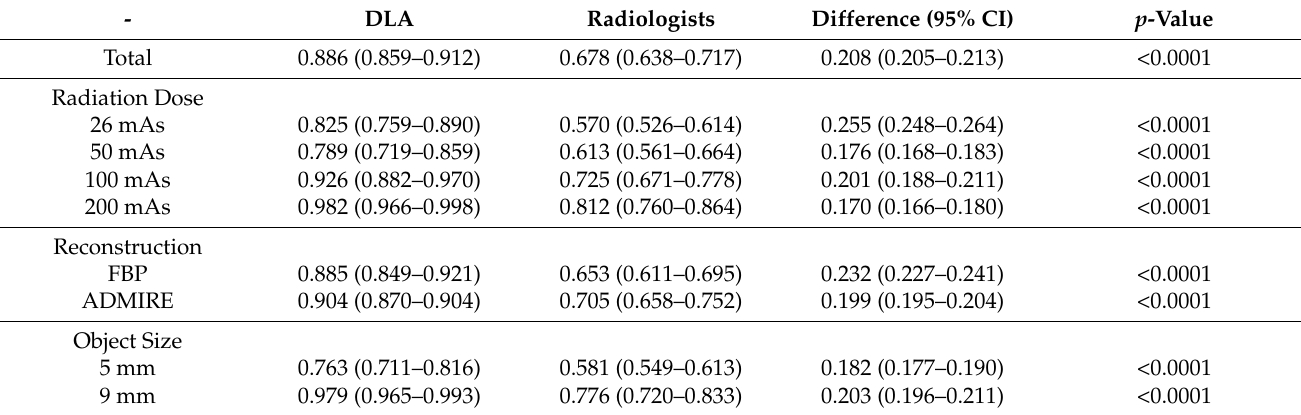
Table 2. Primary